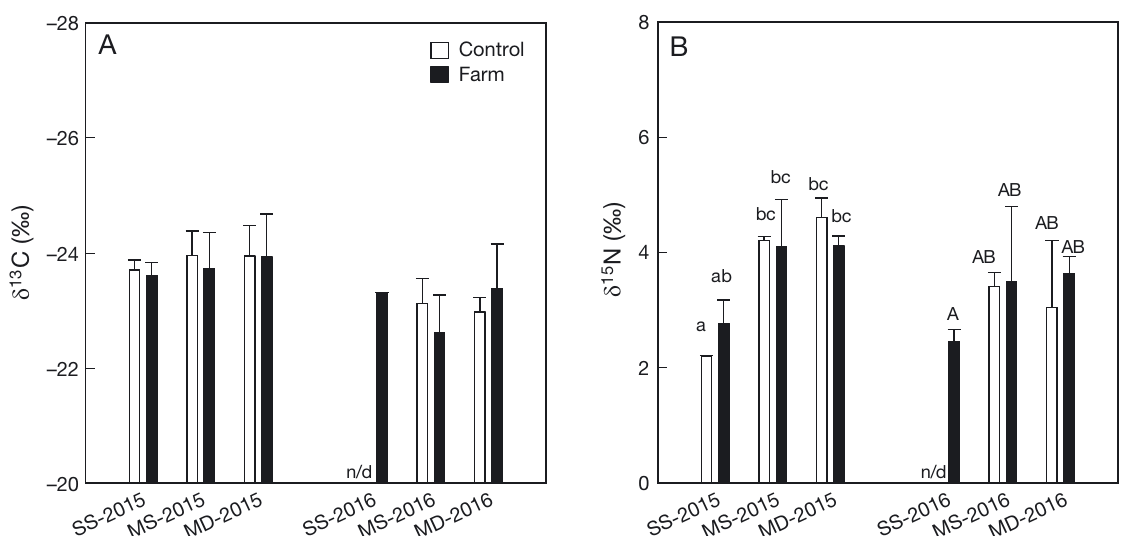
Fig. 2. (A) δ 13 C and (B) δ 15 N values (mean ± SD, n = 3) of sediment surface organic matter collected from ‘farm’ and ‘control’ sites at 3 stations (SS, MS and MD) at scallop farms in Laizhou Bay, China in 2015 and 2016. See Fig. 1 legend for abbreviations of stations. Significant differences (p < 0.05) among groups identified by Student-Newman-Keuls pairwise comparisons are indicated by different letters above the bars. n/d: no data (sampling failed due to practical